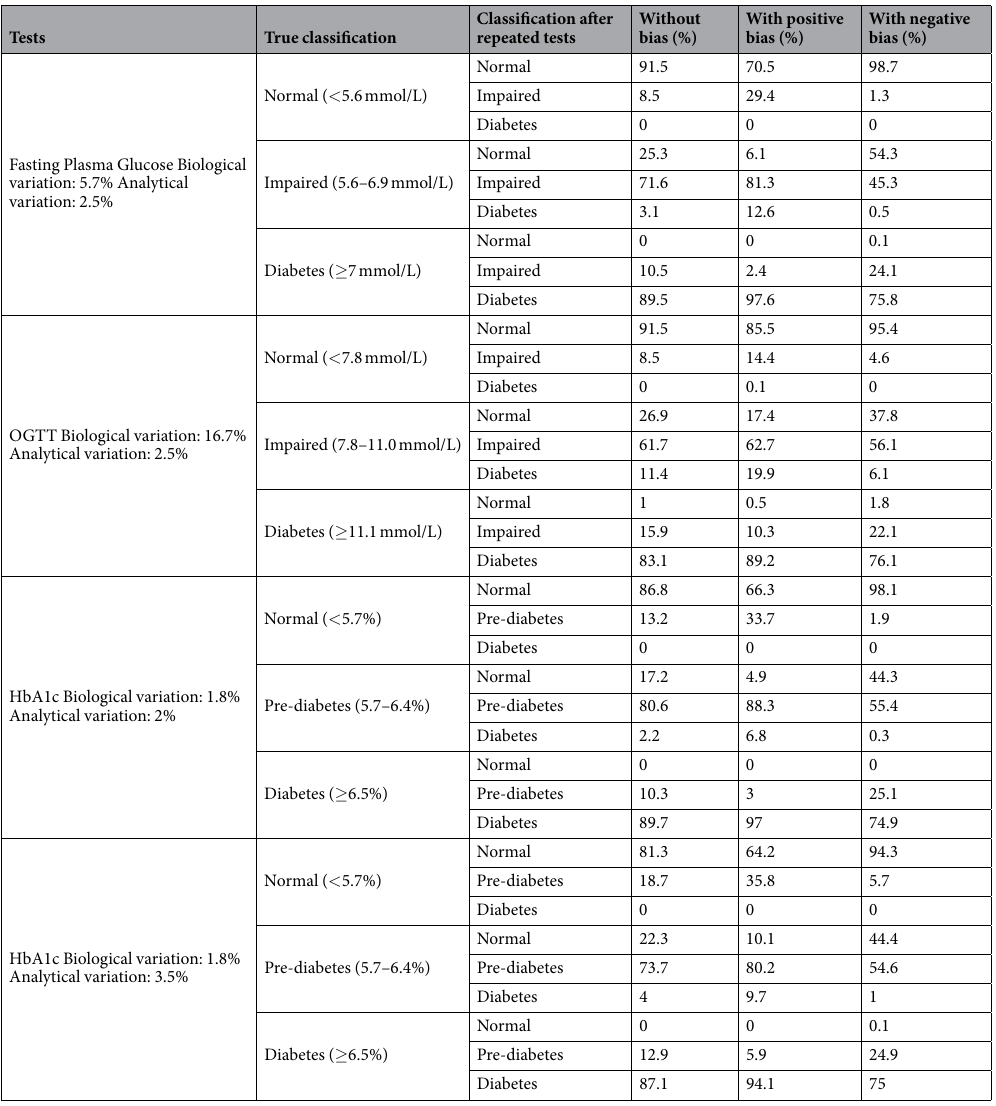
Table 3. Proportion of patients who are misclassified when laboratory testing for diabetes is repeated (American Diabetes Association criteria). A between-laboratory positive bias of + 7% and + 2.5% were introduced for the fasting plasma glucose/oral glucose tolerance test, and HbA1c, respectively. A between-laboratory negative bias of − 6% and − 3% were introduced for the fasting plasma glucose/oral glucose tolerance test, and HbA1c,